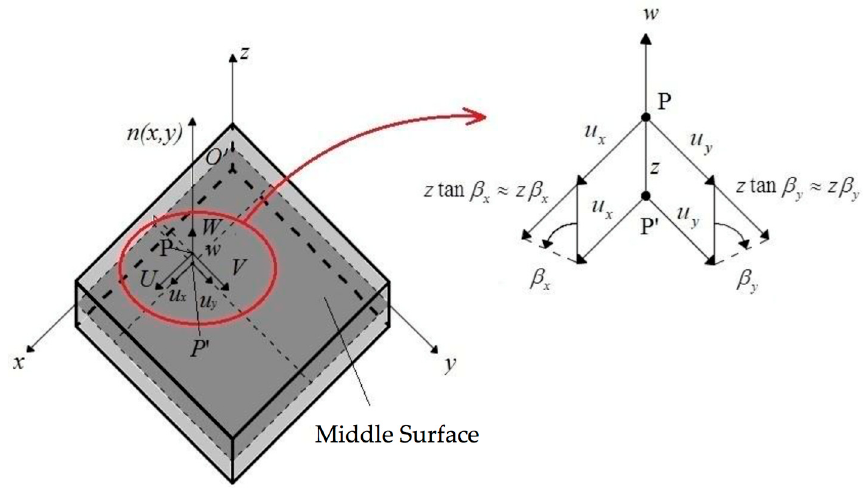
Figure 1. Geometric interpretation of the FSDT kinematic model.